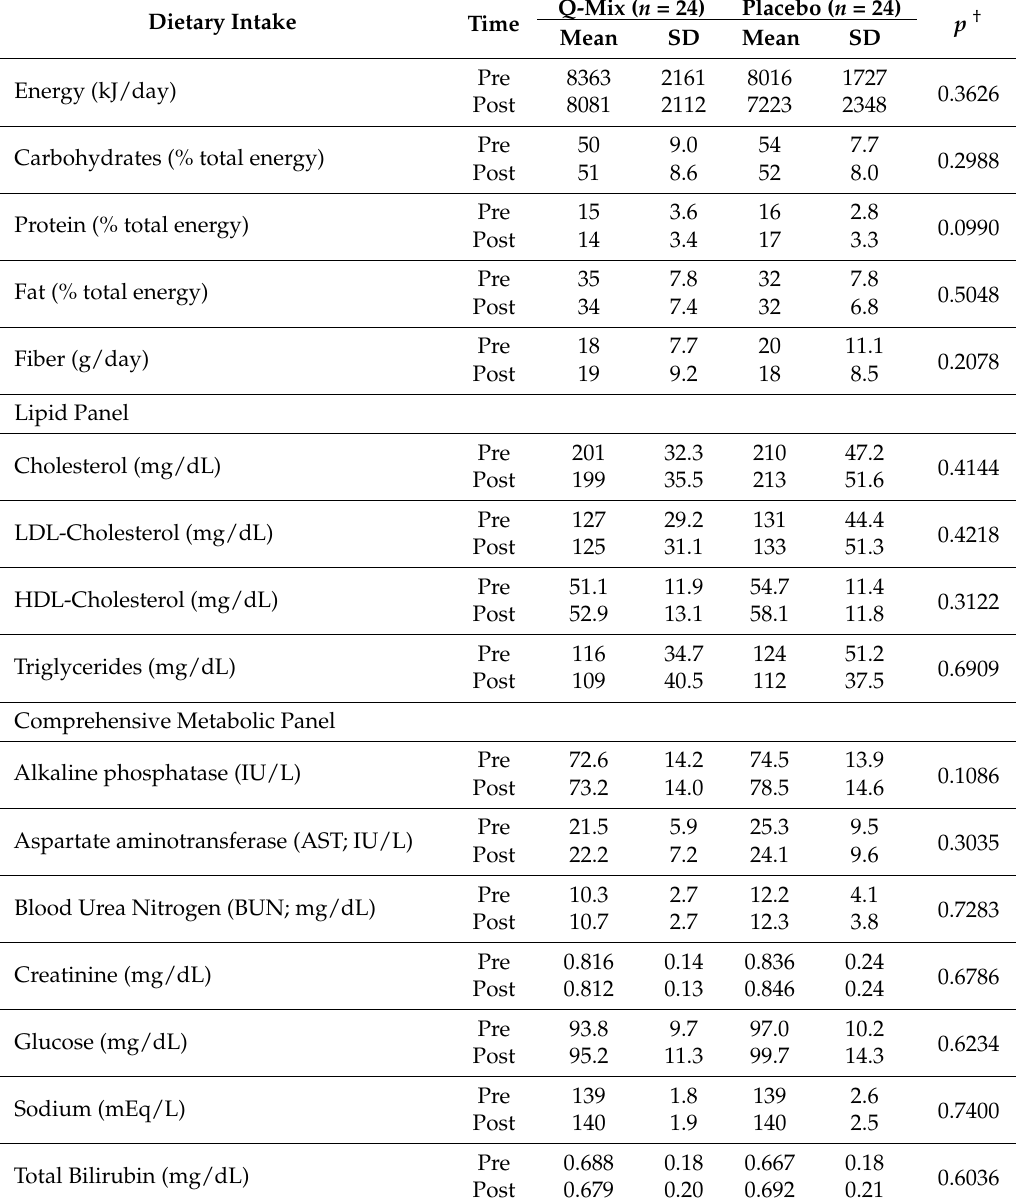
Table 3. Pre- and post-study dietary intake, lipid profile, and selected values from comprehensive metabolic panel by supplement group